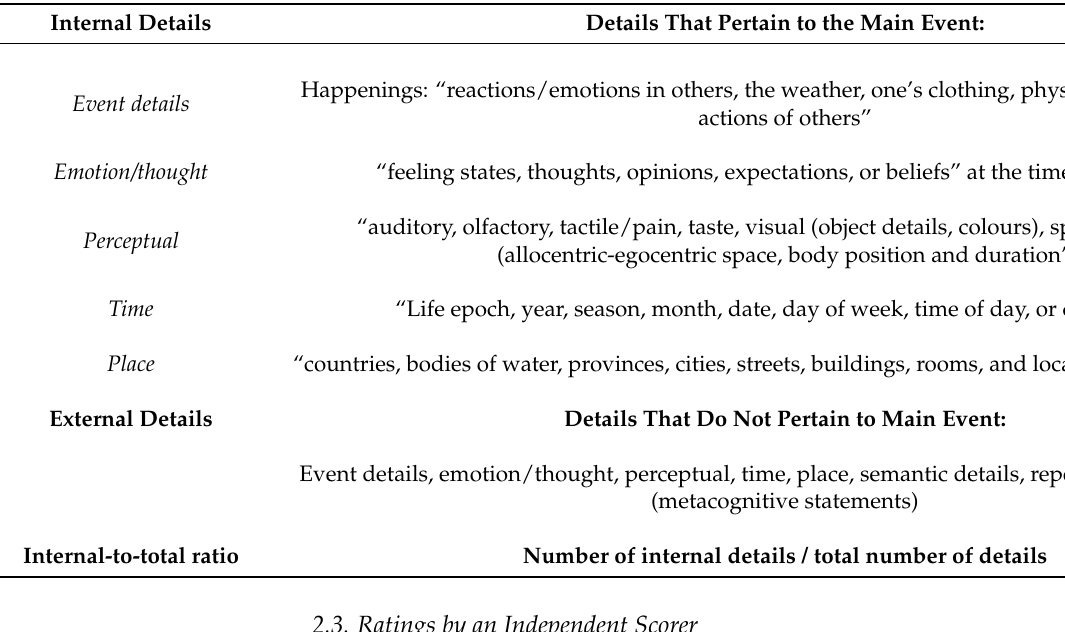
Table 2. Autobiographical interview scoring procedure.